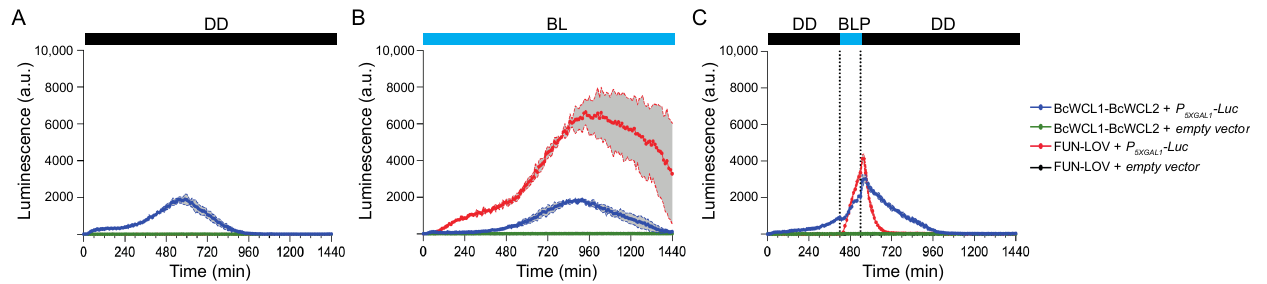
Figure 2. BcWCL1 and BcWCL2 proteins interact in the presence of blue light or its absence. Luciferase expression was measured as luminescence in arbitrary units (a.u.) of the yeast cell cultures. The protein–protein interaction activates luciferase expression controlled by the 5XGAL1 synthetic promoter (P 5XGAL1 ) under three different experimental conditions: ( A ) constant darkness (DD), ( B ) constant blue light (BL), and ( C ) a single blue-light pulse (BLP) of 2 h duration (between dotted lines). In all panels, the FUN-LOV optogenetic switch [32] was used as a positive control of light-mediated protein–protein interaction that activates Luc expression. The average of luciferase expression determined in six biological replicates is shown, with the standard deviation represented as a shaded grey region.